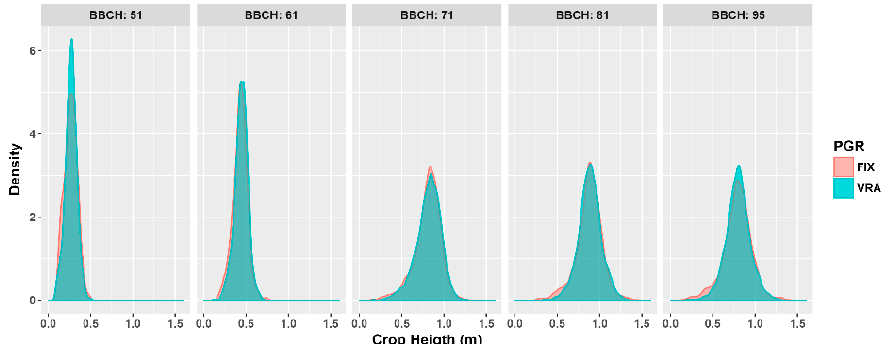
Figure 8. Frequency distribution of crop height in field CF3 under fixed rate and variable rate application of plant growth regulators.